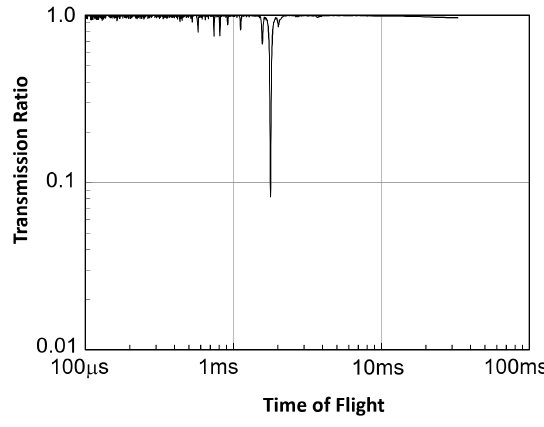
Figure 12. Deduced neutron transmission ratio of 243 Am.